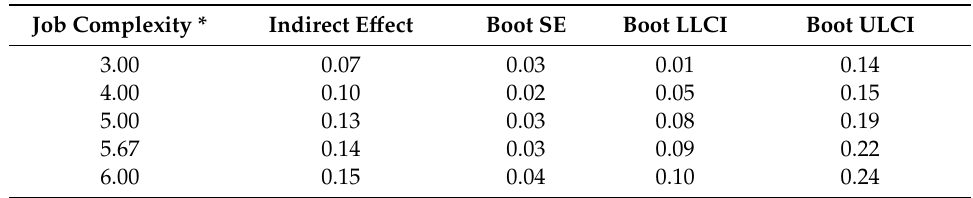
Table 4. Conditional indirect e ff ects of leader–member exchange (LMX), via engagement, on creativity at di ff erent values of job